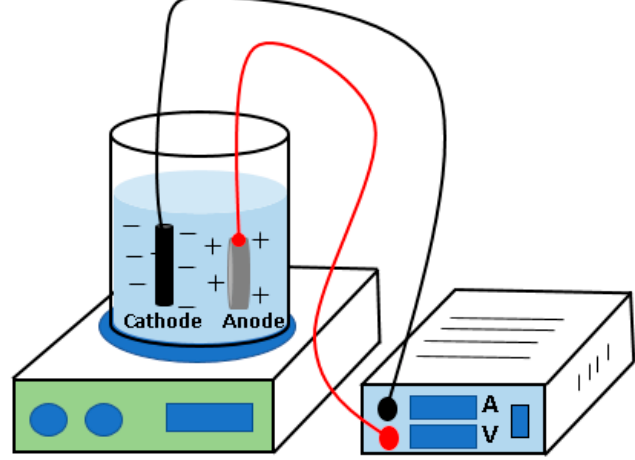
Figure 1. Schematic view of the anodization process.